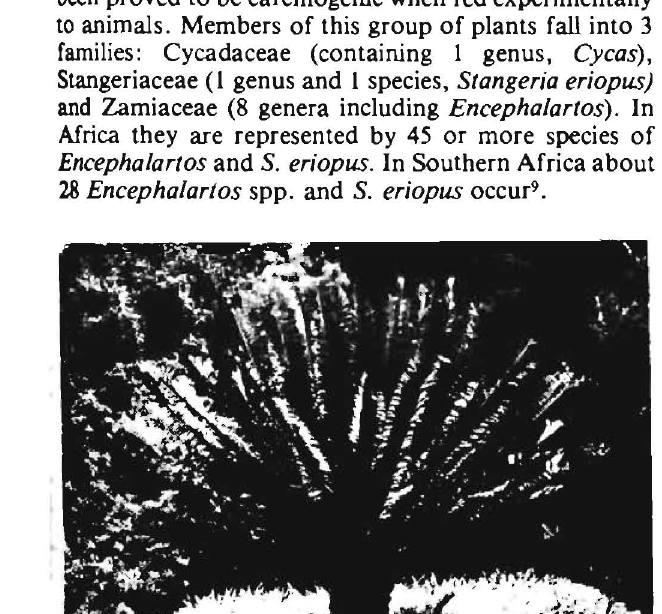
fig. 1. E. transvenosus about 2,5 m in height. National Botanic Gardens, Pretoria.